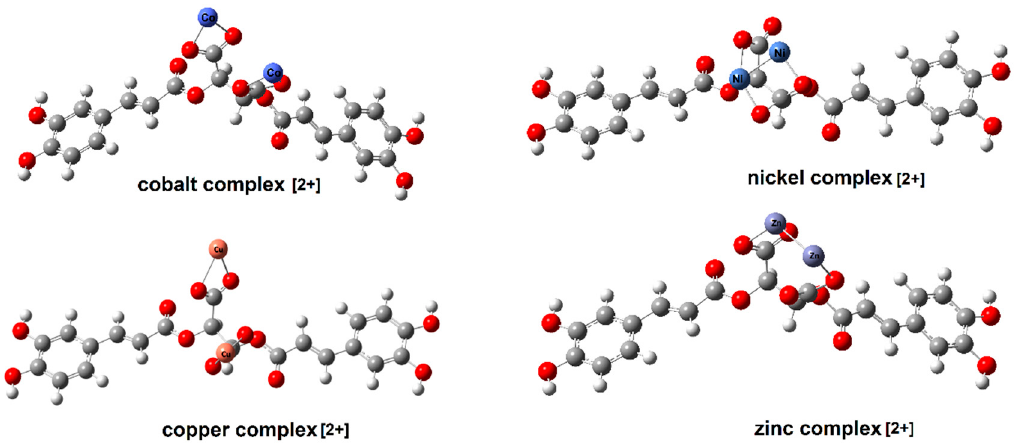
Figure 4. The structure of cation complexes (2 + ) cobalt, nickel, copper and zinc with cichoric acid calculated in HF / 6-311 ++ G(d,p).